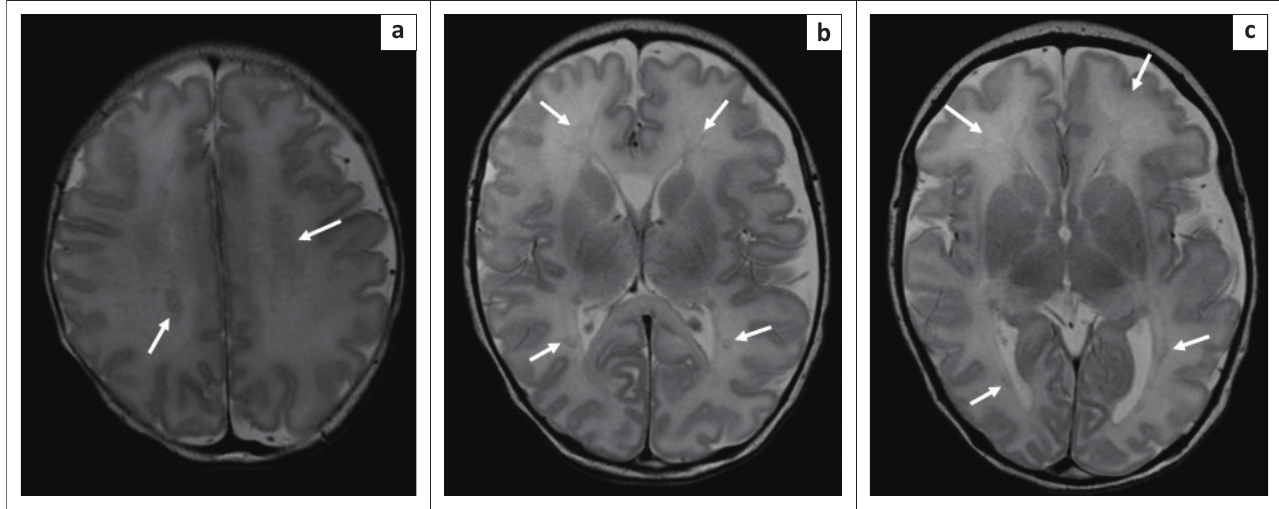
FIGURE 2: Axial T2-weighted MRI of the brain (repetition time msec/echo time msec, 3680/90, 3-mm section thickness) at the level of the high frontal lobes (a), basal ganglia (b) and peritrigonal white matter (c). The images show areas of T2 signal abnormality involving the corpus callosum and the bilateral supratentorial white matter, predominantly the bilateral frontal regions (solid white arrows on all images) with sparing of the thalami.